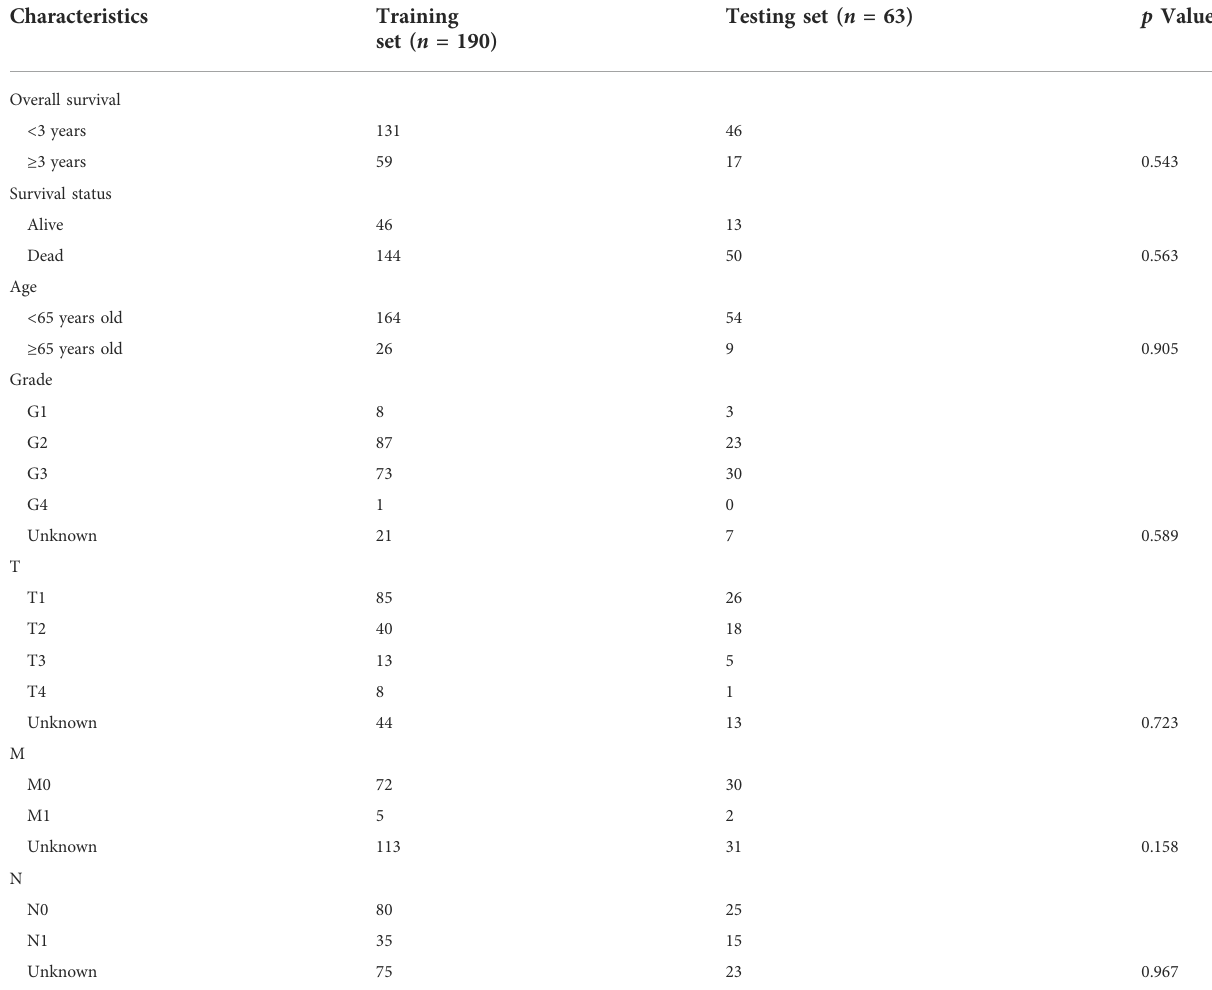
TABLE 2 Comparison between training set and testing set.